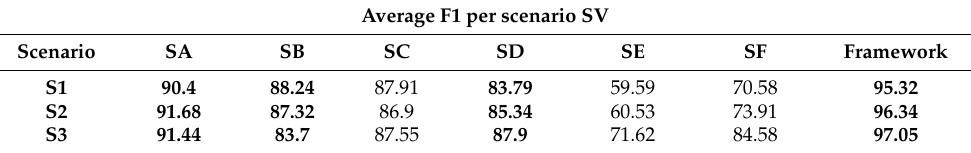
Table 12. Average F1 per scenario